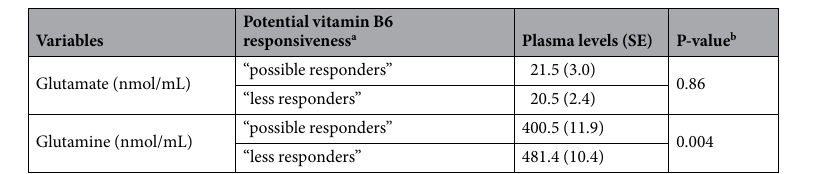
Table 3. Differences in selected plasma amino acids levels according to potential vitamin B6 responsiveness. SE, standard error. a According to the Clinical Global Impression-Improvement scale. b Student t